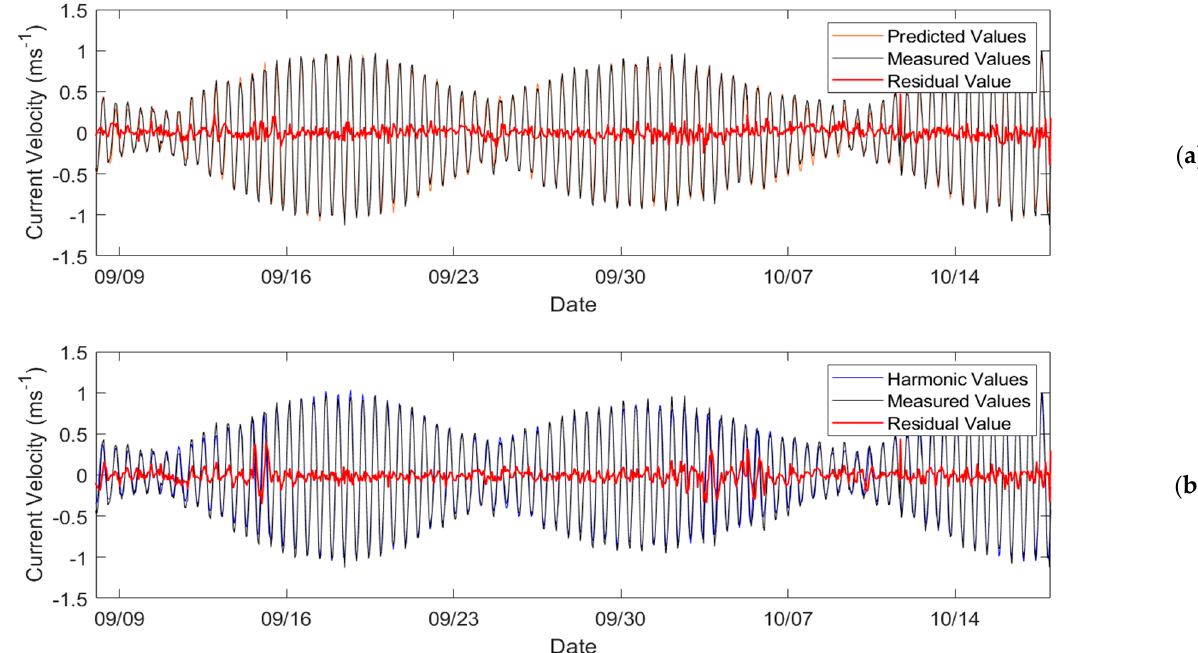
Figure 11. ( a ) Network predicted current, alongside harmonic prediction and residual current between the two. ( b ) Measured tides, alongside harmonic prediction, and residual tide between the two. Blue: harmonic prediction, orange: network prediction, black: measured values, and red: residual value.